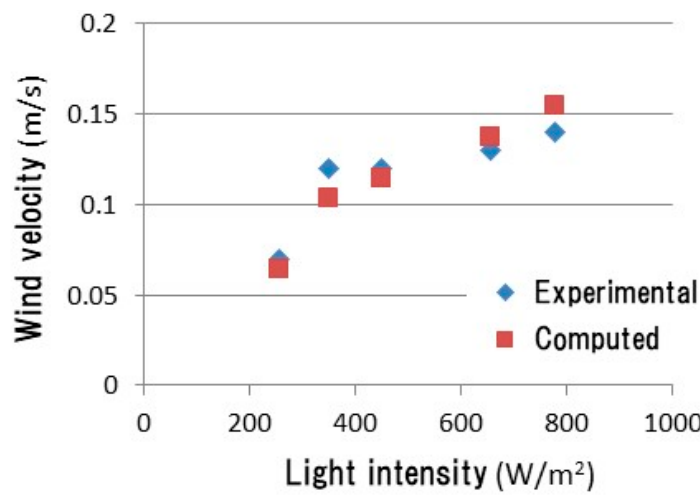
Figure 13. Velocity of generated wind in small-scale OPV-solar chimney as a function of light intensity.